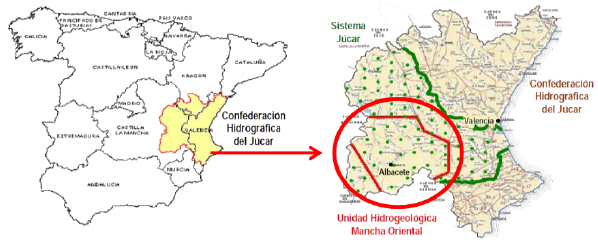
Figure 3. Case study area: Mancha Oriental aquifer in south-eastern